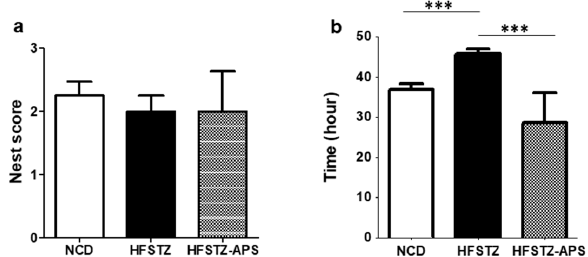
Figure 8. APS improved HFSTZ-prolonged nesting construction time. Nesting behavior for NCD ( n = 7), HFSTZ ( n = 6), and HFSTZ-APS ( n = 3) mice groups were examined. ( a ) Nesting score ( b ) Nestcomplete-construction time. Data are shown as mean ± SEM. *** p < 0.001, significant difference from HFSTZ group.